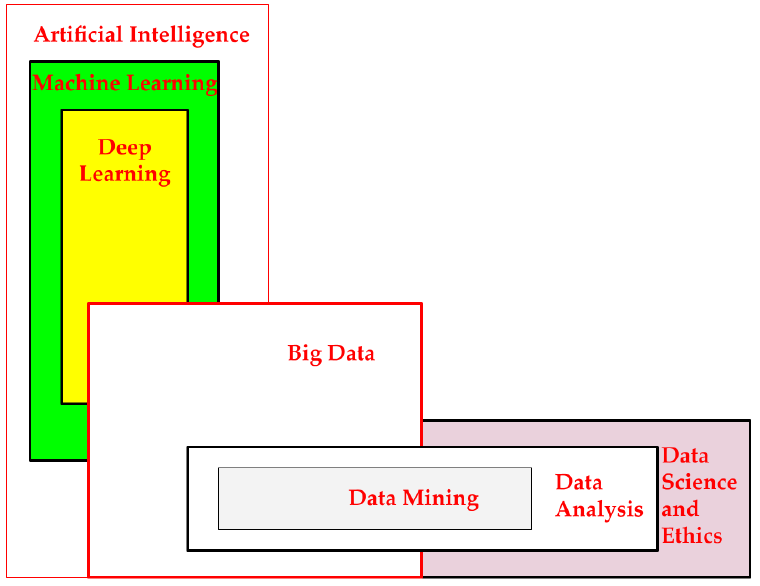
Figure 3. The interplay of Big Data, AI, and data science.